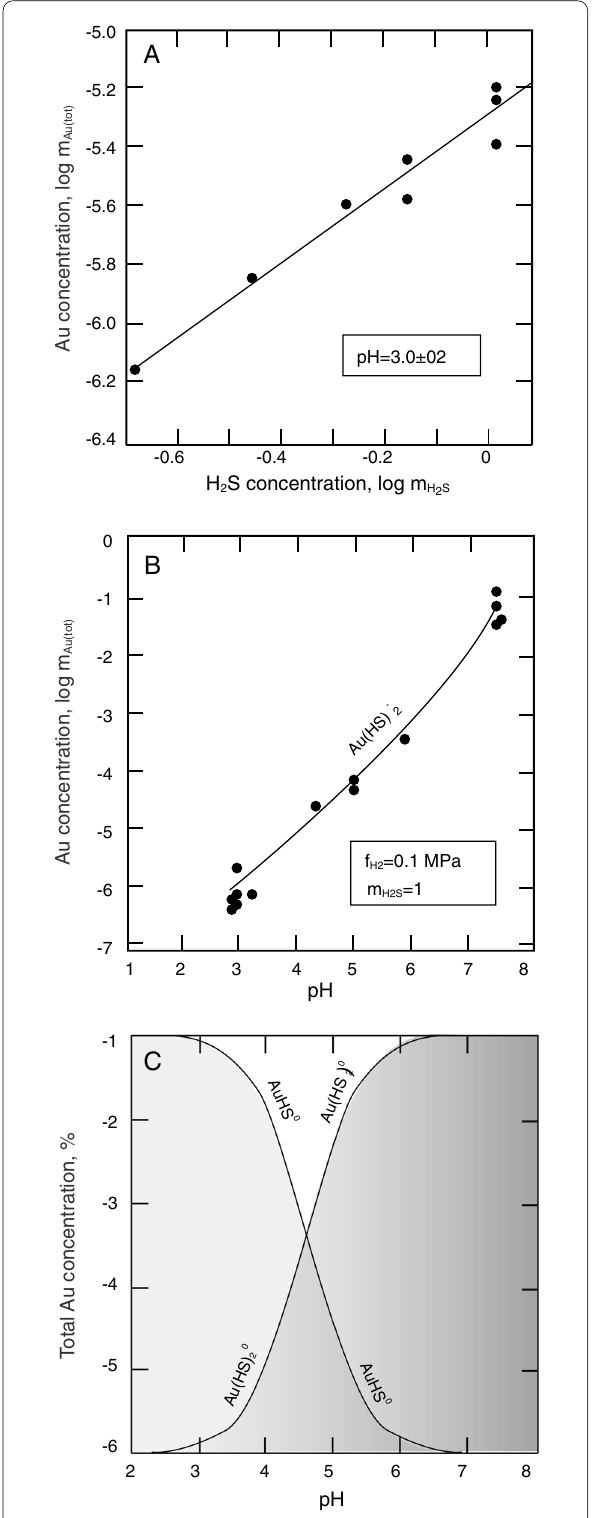
Fig. 27 A . Solubility of Au in H–O–S solutions as a function of H 2 S content, m H2S , at 450 °C and 100 MPa and pH 3 0.2. B . Solubility of = ± Au in H–O–S solutions as a function of pH at 450 °C and 100 MPa with molality of H 2 S, m H2S 1, and hydrogen fugacity, f H2 0.1 MPa. C . = = Speciation of Au-sulfide complexes in H–O–S solutions as a function of pH and Au concentration. Modified after Pokrovski et al. (2008) and Trigub et al.